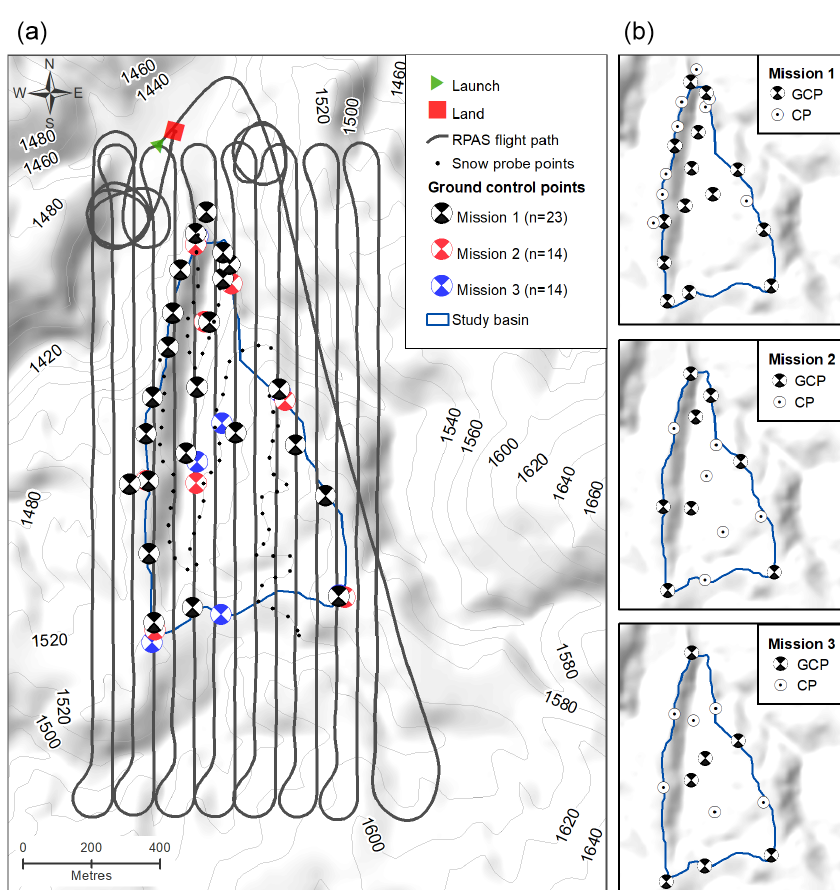
Figure 2. Typical flight path for the mapping of the study catchment using the Trimble UX5, GCP network established for each flight mission, and reference snow depth locations. Flight log is from the spring flight mission. The configuration of the ground control point (GCP) and check point (CP) assignment for the triangulation of each flight is shown in the panels on the right-hand